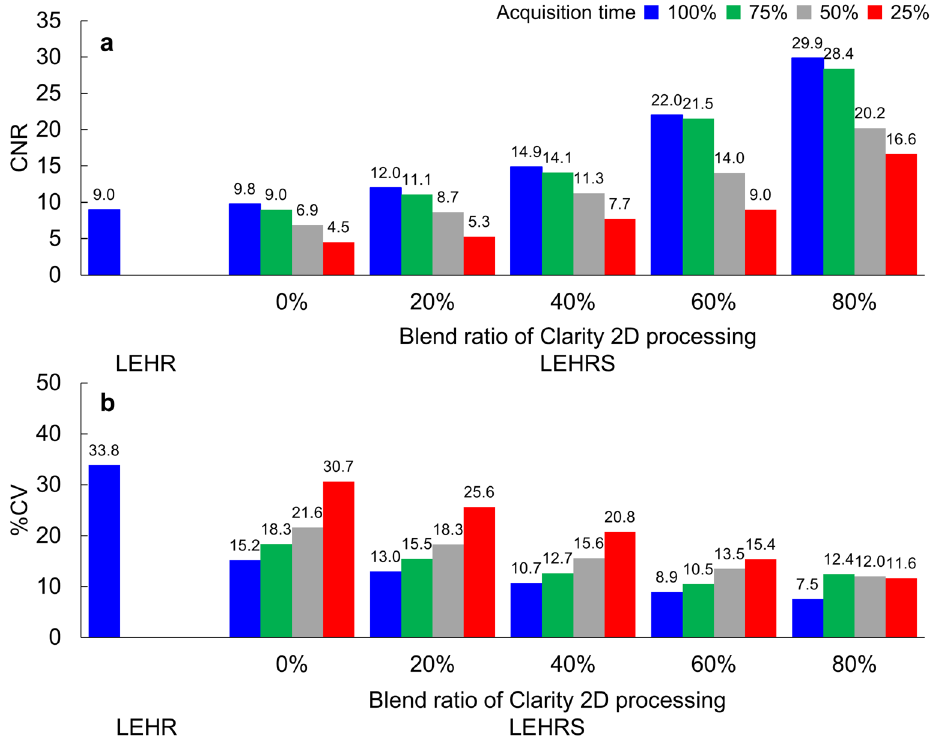
Figure 4. Quantitative evaluation of tumor bone with a reference part for different acquisition times in the SwiftScan planar image. ( a ) Contrat to noise ratio (CNR), ( b ) the percent of the coefficient of variance (% CV). LEHR low-energy high-resolution, LEHRS low-energy high-resolution and